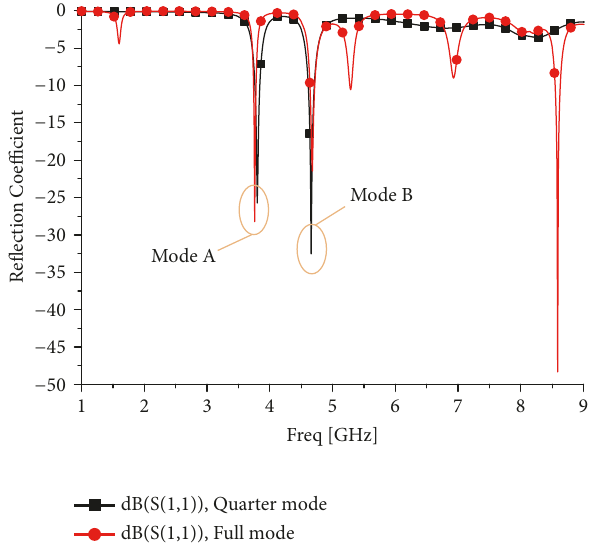
Figure 5: Comparison of reflection coefficient between full-mode and